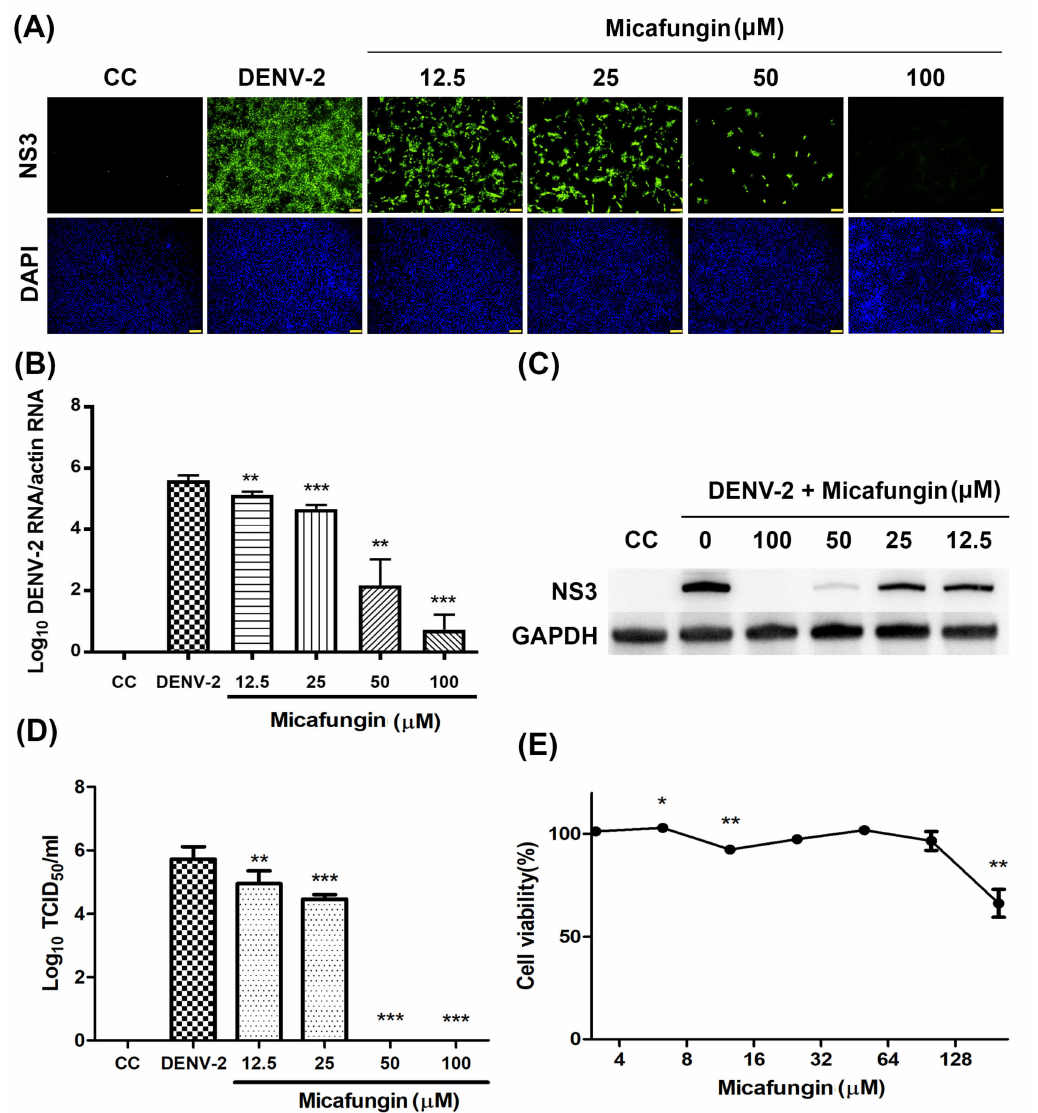
Figure 1. Anti-dengue virus serotype 2 (DENV-2) activity and cytotoxicity of micafungin in Vero cells: ( A ) DENV NS3 antibodies (upper) determined DENV-2 infection and DAPI (below) determined the nuclear by IFA; ( B ) RT-qPCR assay results of DENV-2 RNA; ( C ) Protein expression of dengue NS3 and GAPDH, as detected by Western blot analysis; ( D ) TCID 50 assay results of DENV-2 yield; ( E ) Cytotoxicity of micafungin following treatment for a period of 3 days, as measured using cell viability assay. All data were obtained from at least three independent experiments, where significance was indicated as follows: * p < 0.05; ** p < 0.01; *** p < 0.001. Scale bar: 100 µ